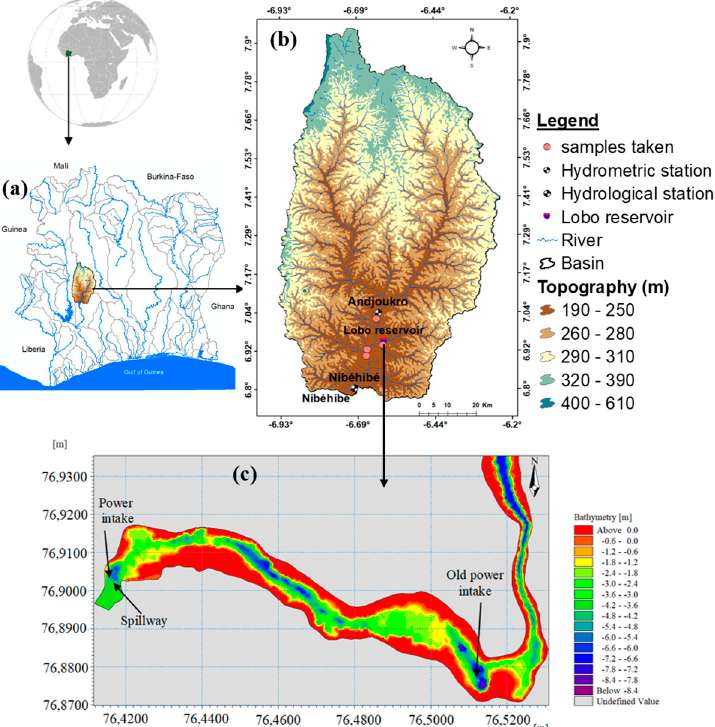
Figure 1. Location of the research area. ( a ) Lobo River basin against the Côte d’Ivoire map. ( b ) Lobo river basin at Nibéhibé. ( c ) Lobo River reservoir.